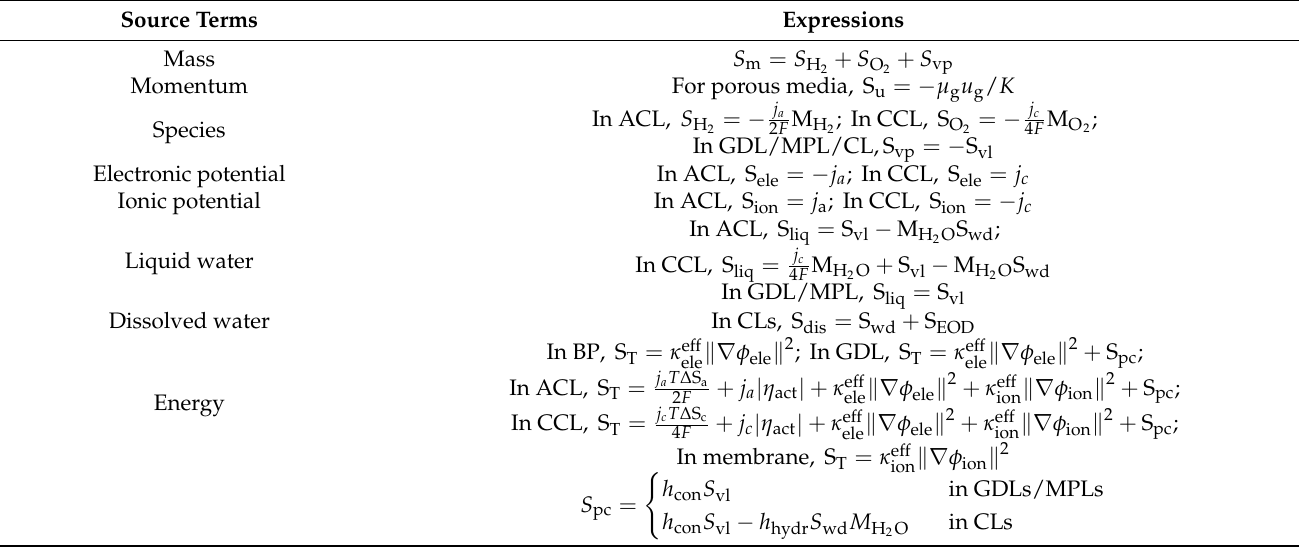
Table 3. Source terms of the governing equation.